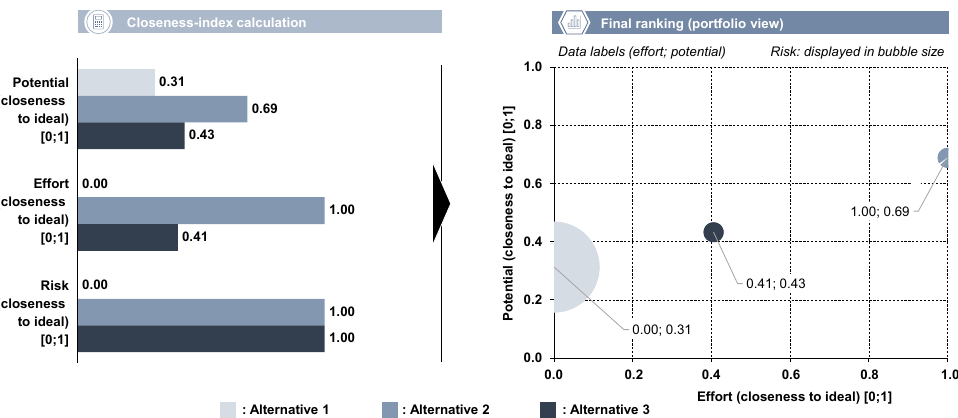
Figure 9. Results of the use case application of the approach in the form of closest-to-ideal values and a portfolio analysis.